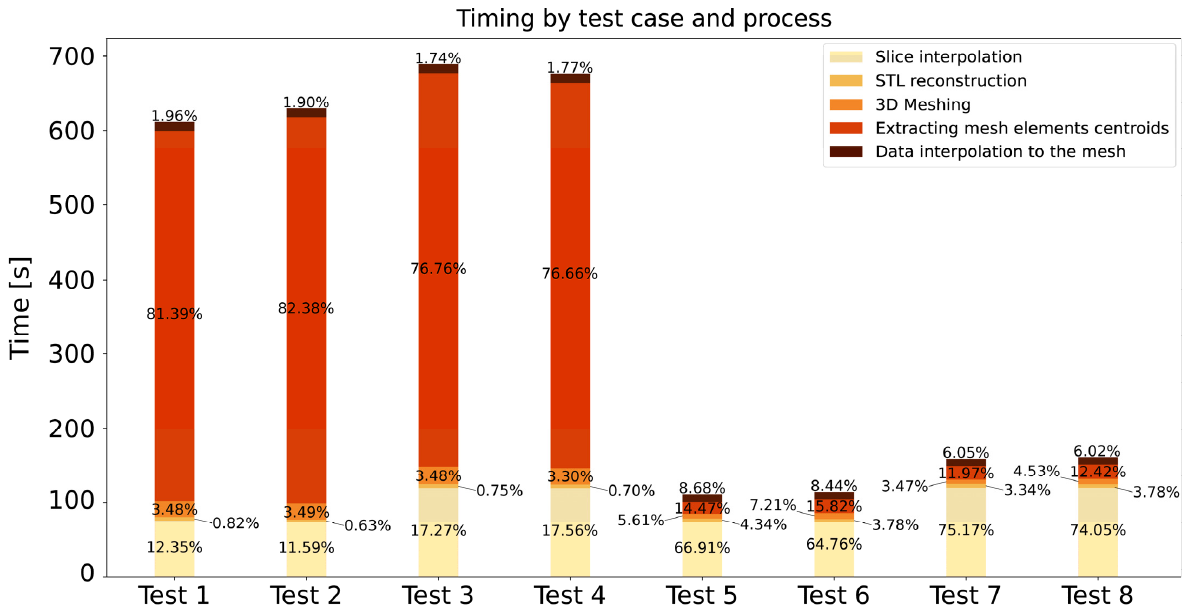
Figure A2. Analysis of the computation time for each test case separated by each of the processes. The first four cases correspond to the finer mesh (around 430,000 elements), and the last four correspond to the coarser mesh (around 65,000 elements). These results clearly show that the extraction of the centroids of the elements is the bottleneck in the case of the finer meshes, accounting for more than 75% of the total computational time.